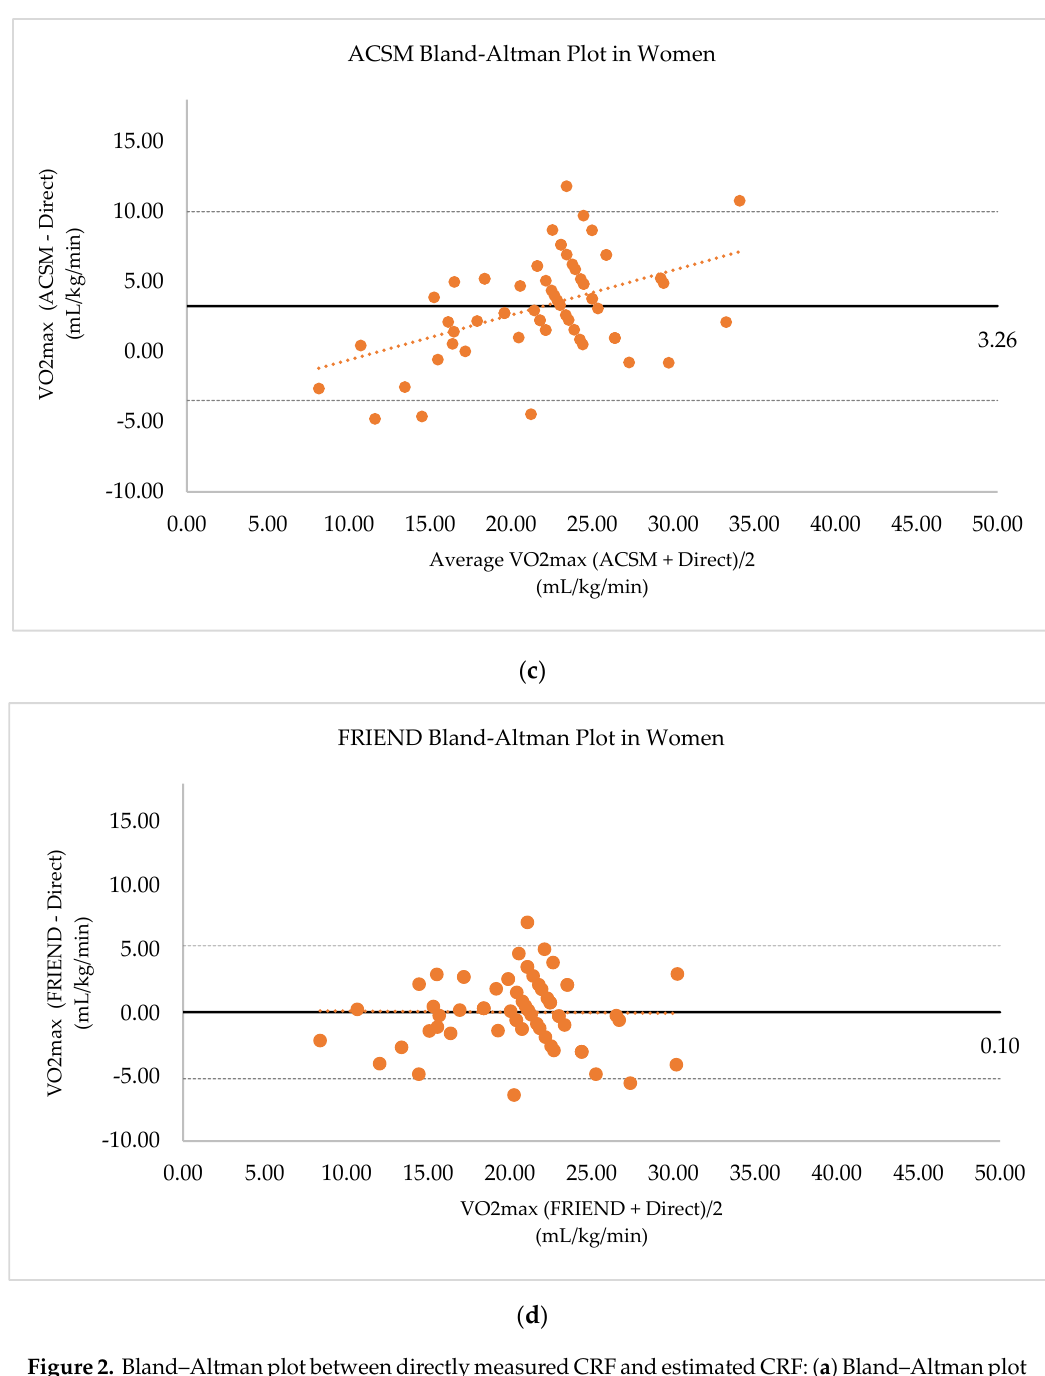
Figure 2. Bland – Altman plot between directly measured CRF and estimated CRF: ( a ) Bland – Altman plot between directly measured CRF and estimated CRF by ACSM equation in men; ( b ) Bland – Altman plot between directly measured CRF and estimated CRF by FRIEND equation in men; ( c ) Bland – Altman plot between directly measured CRF and estimated CRF by ACSM equation in women; ( d ) Bland – Altman plot between directly measured CRF and estimated CRF by FRIEND equation in women. dotted line; linear regression line, horizontal to X-axis linear line; mean difference value, horizontal to X-axis dotted line; upper and lower limits of agreement.